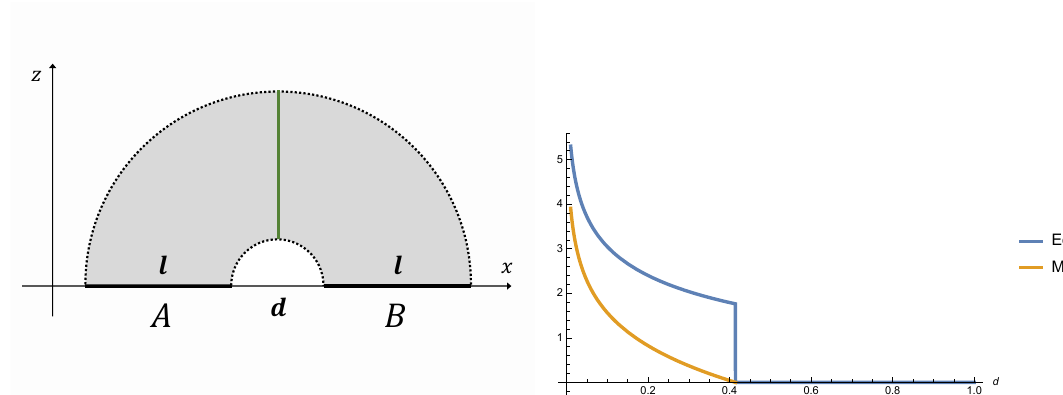
Figure 2 . The setup for the computation of the holographic EoP E W ( A : B ) in Poincar(cid:19)e AdS 3 (the left picture), and the plots of E W ( A : B ) (the blue curve in the right picture) and half of holographic mutual information I ( A : B ) (the orange curve in the right picture) as the functions of the distance ( d ) between A and B . Both holographic EoP and mutual information show phase transition behaviors, though only the EoP is discontinuous. We set c = 1 and the size l = 1 with the p 6 transition point d (cid:3) = 2 (cid:0) 1. After the phase transition, EoP and mutual information become zero.